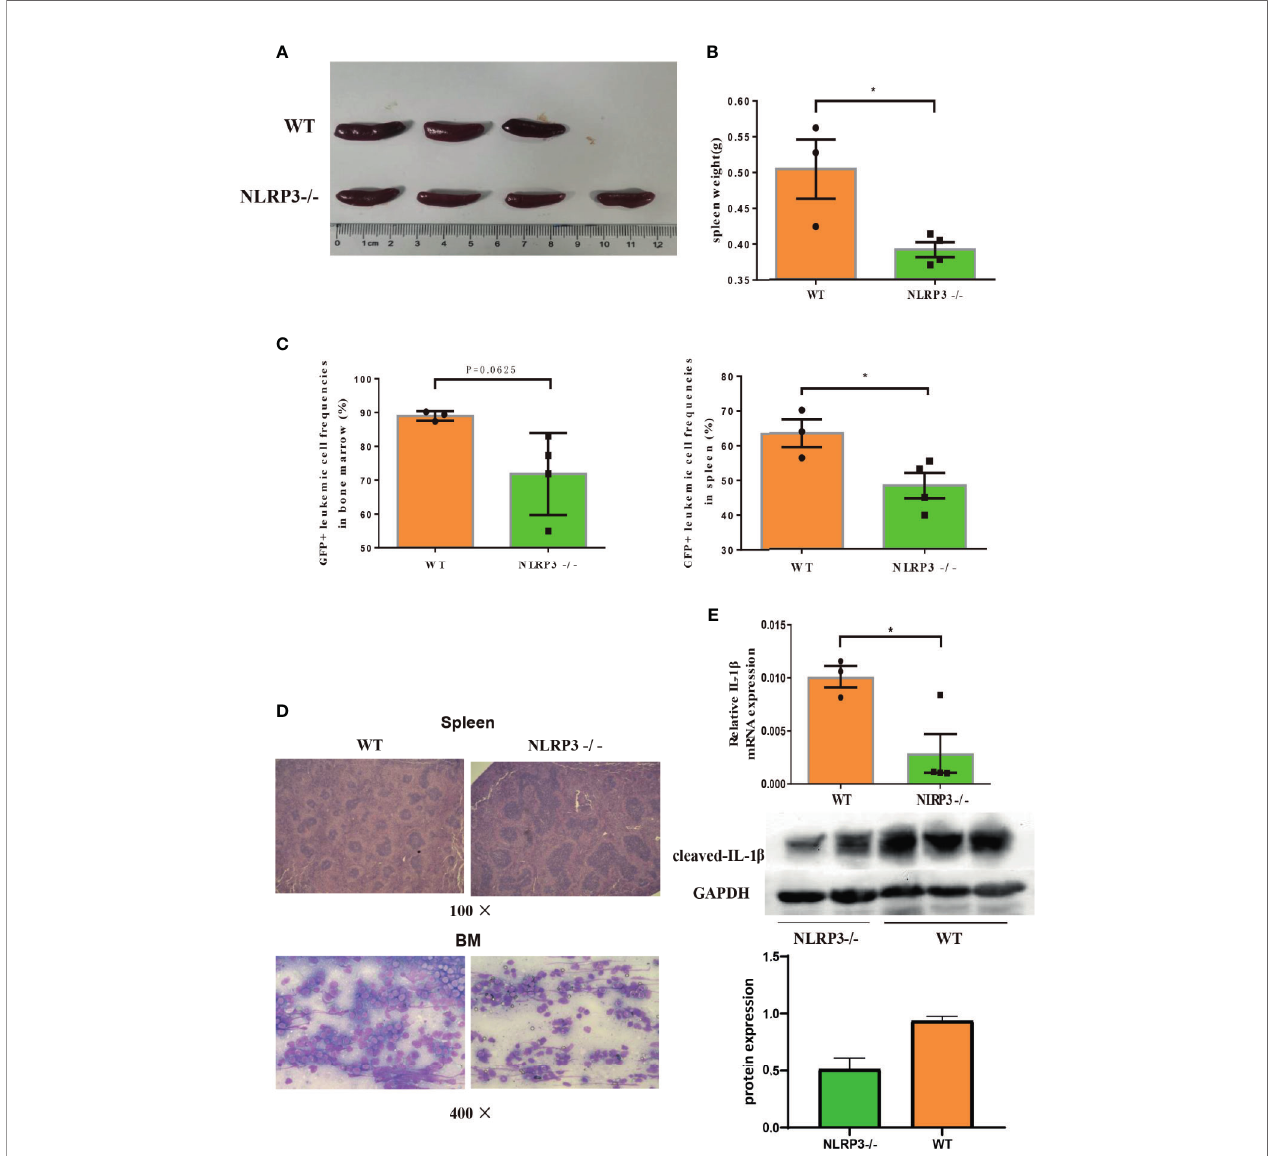
FIGURE 4 | Knockout of NLRP3 attenuates leukemia burden in AML mice. (A) Representative photographs of spleen from WT mice (n=3) and NLRP3-/- mice (n=4). (B) The weight of spleens of WT mice (n=3) and NLRP3-/- mice (n=4). (C) The leukemia cells (GFP+ cells) in spleen and bone marrow from WT mice (n=3) and NLRP3-/- mice (n=4). (D) Hematoxylin and eosin-stained histopathology sections of a representative spleen and bone marrow from WT and NLRP3-/- mice (100× or400×). (E) The mRNA and protein expressions of IL-1 b by qRT-PCR and western- blot in bone marrow of WT and NLRP3 -/- mice. *P <